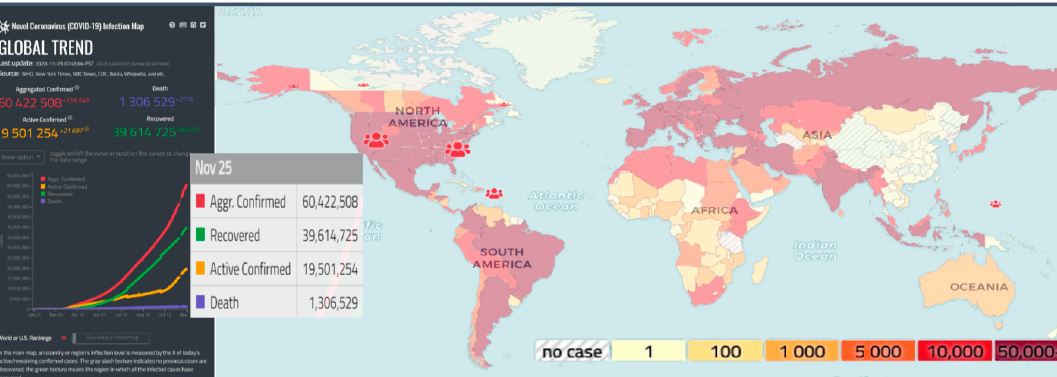
Figure 33. Changes in the number of practicing dentists in the USA in the period 1993–2017. Processes 2020 , 9 , x FOR PEER REVIEW